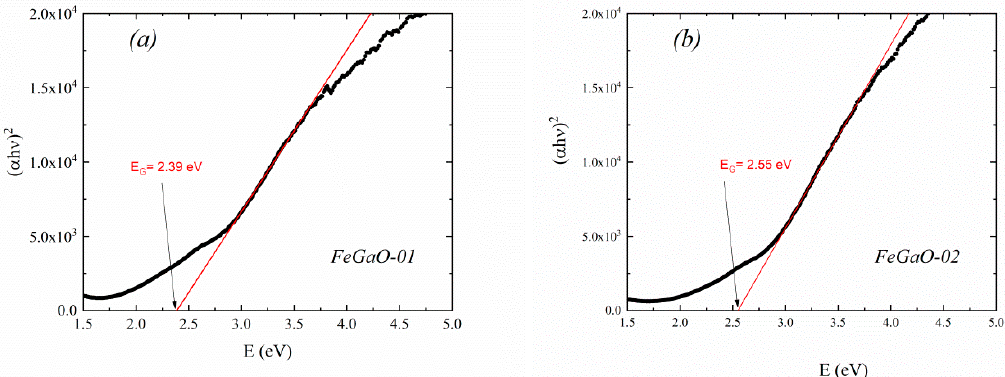
Figure 4. UV-vis. spectra of (a) FeGaO-01 and (b) FeGaO-02 samples. Figure 4. UV-vis spectra of the ( a ) FeGaO-01 and ( b ) FeGaO-02